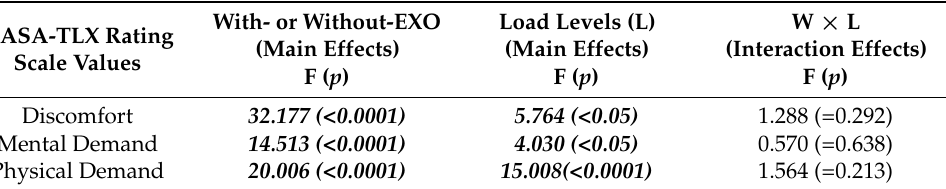
Figure 11. The comparison of weight factors between without-exo and with-exo walking conditions. Table 4. Summary of Two-Way ANOVA Results for the Main and Interaction Effects on the Discomfort, Mental Demand and Physical Demand. ( Note: The significant differences were indicated as bold and italic style. F means F test value. Lower-case p indicates statistical significance.)